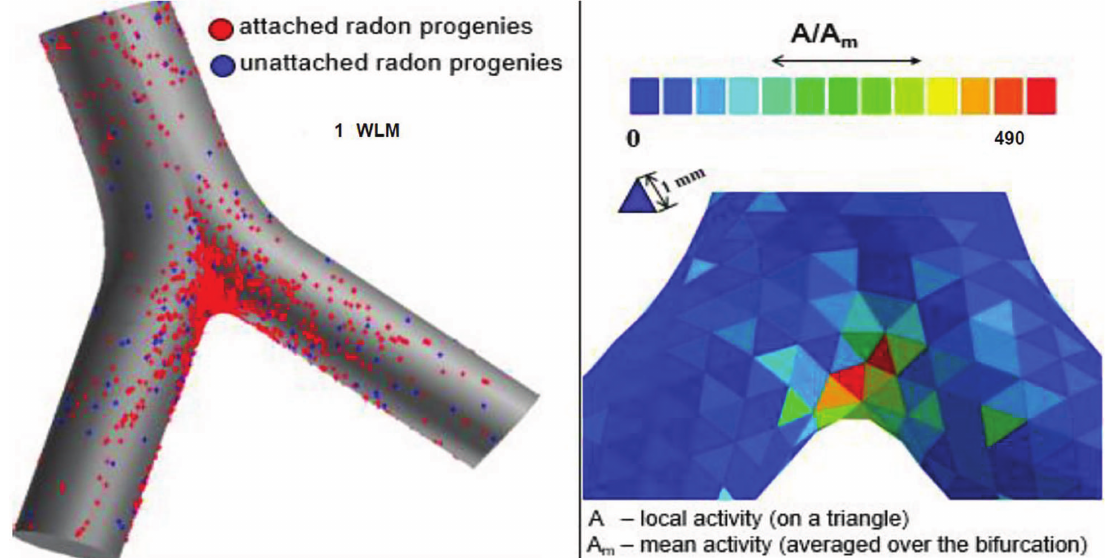
Fig. 4. Deposition pattern of the inhaled radon progenies in a central bronchial airway bifurcation (left) and colour map of the deposition enhancement factors